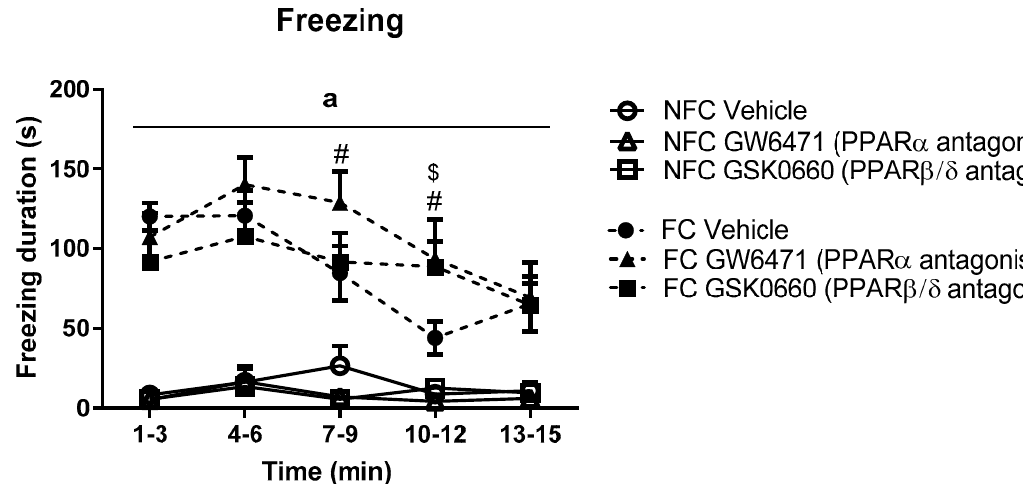
Figure 3. Temporal profile of the effects of fear conditioning and systemic administration of selective PPAR α and PPAR β / δ antagonists on freezing in non ‐ fear conditioned (NFC) and fear conditioned (FC) rats. Post hoc analysis with Student Newman ‐ Keuls revealed that all formalin ‐ injected FC groups exhibited significantly greater duration of freezing compared with NFC counterparts ( a p < 0.001). Treatment with GW6471 in FC rats significantly increased freezing duration in two of the 3 ‐ min time bins (# p < 0.05, vs. FC Vehicle), and treatment with GSK0660 significantly increased freezing duration in one of the 3 ‐ min time bins ($ p < 0.05, vs. FC Vehicle). Data are expressed as mean ± S.E.M ( n = 7–9 per group).